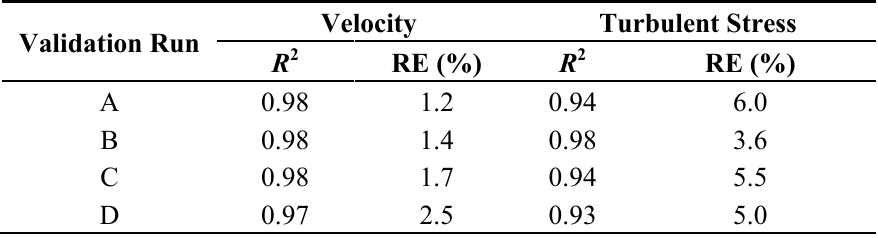
Table 2. Error statistics for kelp-type structure module validation runs ( R 2 denotes the coefficient